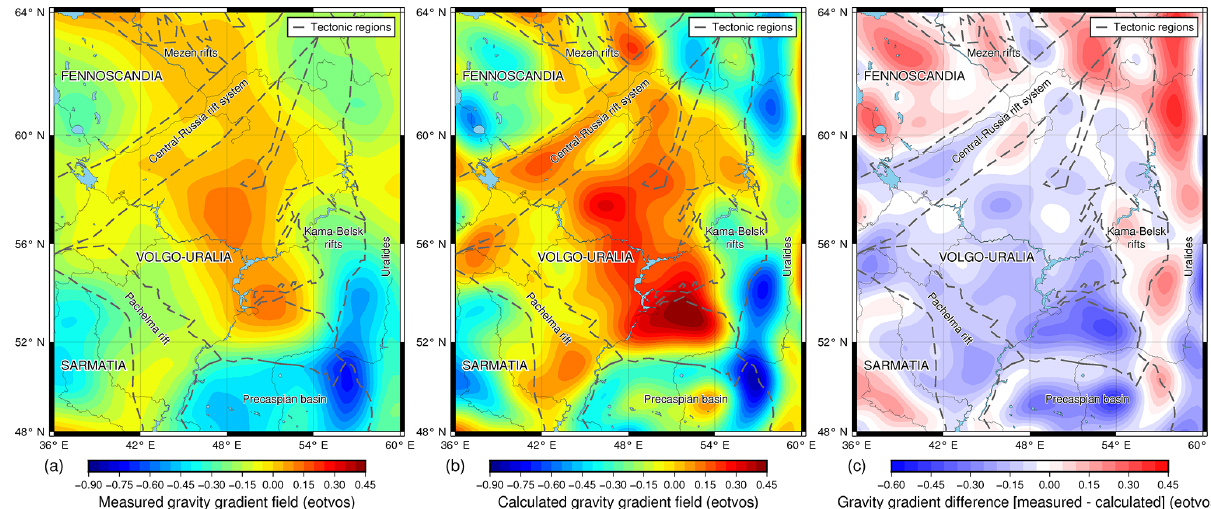
Figure 7. Comparison between measured and calculated gravity gradient fields. (a) GOCE topographically corrected vertical gravity gradient at 225km height (Bouman et al., 2016). (b) Calculated topographically corrected vertical gravity gradient field from IGMAS + 3D model. (c) The difference between measured and calculated gravity gradient fields.